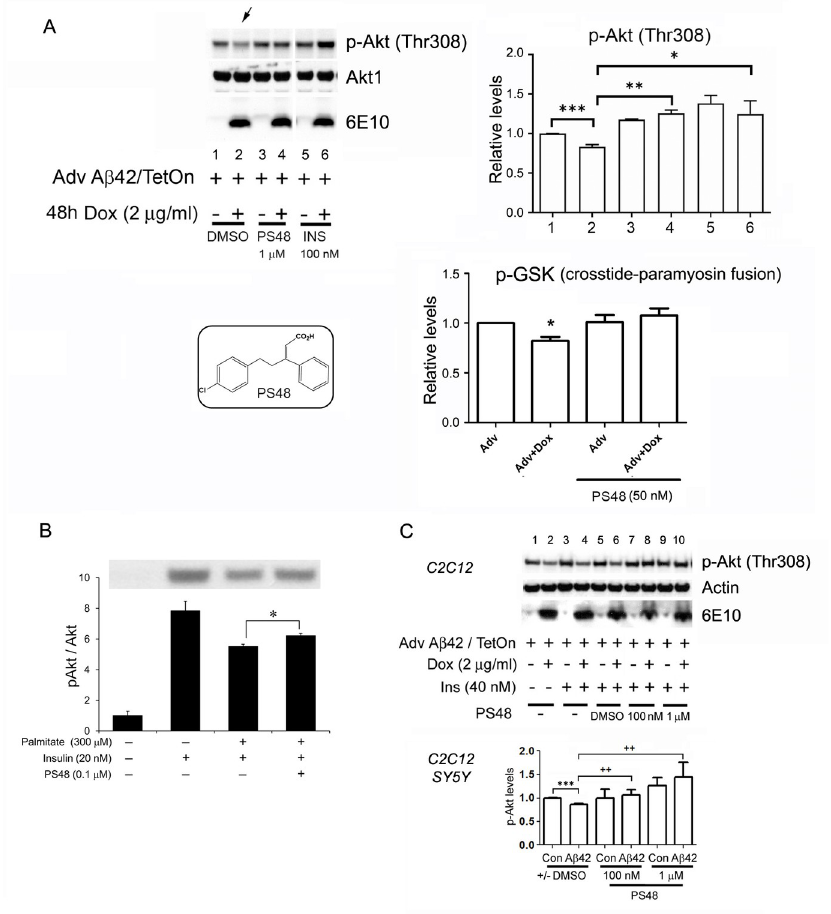
Fig 1. PS48 or Insulin restores Akt activation in β -amyloid expressing cells. 1A, left . SH-SY5Y cultures were infected with Adenovirus (Adv) encoding A β 42 (24–36 hrs) and induced with Doxycycline (46 additional hrs). Amyloid bearing cells show inhibited Akt phosphorylation (lane 2 arrow). PS48 (1 μ M) or high dose Insulin (100 nM) added 2 hrs before doxycycline induction (pre-treatment) restores Akt activation levels in cells expressing A β 42 (lane 4 and 6). Low dose Insulin 40 nM (stimulation) is added to all cultures 20 min prior to harvest. PS48 alone does not over-stimulate Akt (lane 3 vs. 1). 1A, right . Quantification of restored inhibited Akt activation by PS48 and Insulin. pT308 Akt levels are normalized RFU, (relative fluorescence units). n = 3 experiments. Error bars are 1 SE relative to lane 1 (control). Brackets indicate individual t-tests comparing A β expression result (lane/bar2) to: control (lane/bar1), PS48 (lane/bar 4) and Insulin (lane/bar 6) additions. ��� p < .001, �� p = .01, � p < .05, t-test. Insulin increases pAkt T308 over control (p = .02, lane/bar 5 vs.1). PS48 also has a stimulatory effect (p < .01, lane/bar 3 vs.1). ANOVA 1-way: P = .03, F3.7; 2-way: P = .06, F = 3.1(between groups), P = .49 (within treatments, ie. replicates). 1A , below , in vivo-in vitro coupled assay of Akt activity. Akt was immunoprecipitated from SH-SY5Y cells infected with Adv. Phosphorylation of GSK3 α / β consensus peptide proceeded in vitro after adding 200 μ M ATP to the immunoprecipitate. PS48 pre-treatment (50 nM), added to cells 2 hrs. before Doxycycline addition, prevented the inhibtion of peptide phosphorylation by A β 42. (Western not shown, n = 3, � p < .05 vs. control (Adv. alone). PS48 structure, left. 1B . Non-amyloid-based insulin resistance model. Primary rat cortical neurons (PCN) exposed to fatty acid neurotoxin, palmitate (300 μ M). PS48 (100 nM, 24 hrs) partly reversed inhibition of Akt Ser473 phosphorylation by palmitate, in insulin-stimulated cells (20nM, 15 mins before lysis). Identical result in ceramde (50 μ M)-treated PCNs, not shown). ( � p < .05, n = 3). 1C. SH-SY5Y and C 2 C 12 cells (representative Western) were used to test dose dependency of PS48 (1 μ M, 100 nM, 10 nM). A β 42 expression inhibits the insulin-stimulated phosphorylation (activation) of Akt (lanes 4 vs.3 and 6 vs.5 were combined to correspond to bar 2 vs.1). PS48-, doxycycline-, Insulin- additions and harvest as above. Data from both cell types were combined for the bar graph. PS48 100 nM and 1 μ M (10 μ M, not shown) each significantly overcome the A β 42 effect (lanes 8 and 10 vs. 4 or 6). Bar graph: ��� p < .005, A β vs Con; ++ p < .01, PS48/A β (bars 4 and 6) vs. vehicle/A β 42 (bar 2). DMSO is vehicle control. (n =